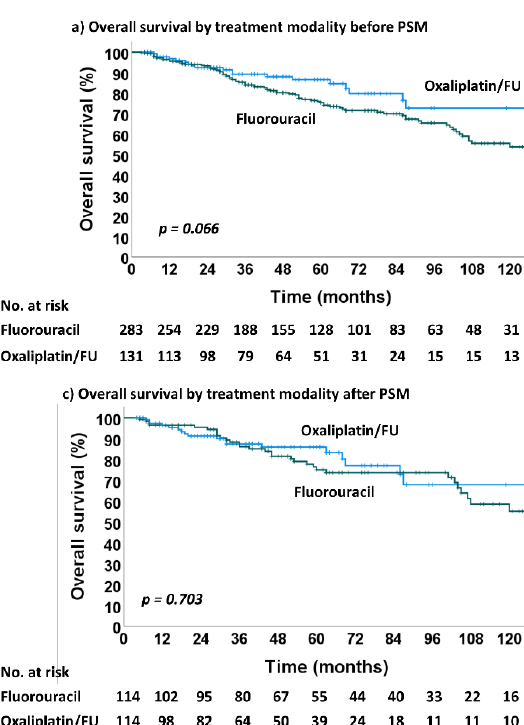
Figure 2. Overall survival and disease-free survival of the study population: a ) overall survival by treatment modality before PSM; b ) disease-free survival by treatment modality before PSM; c ) overall survival by treatment modality after PSM; d ) disease-free survival by treatment modality after PSM.